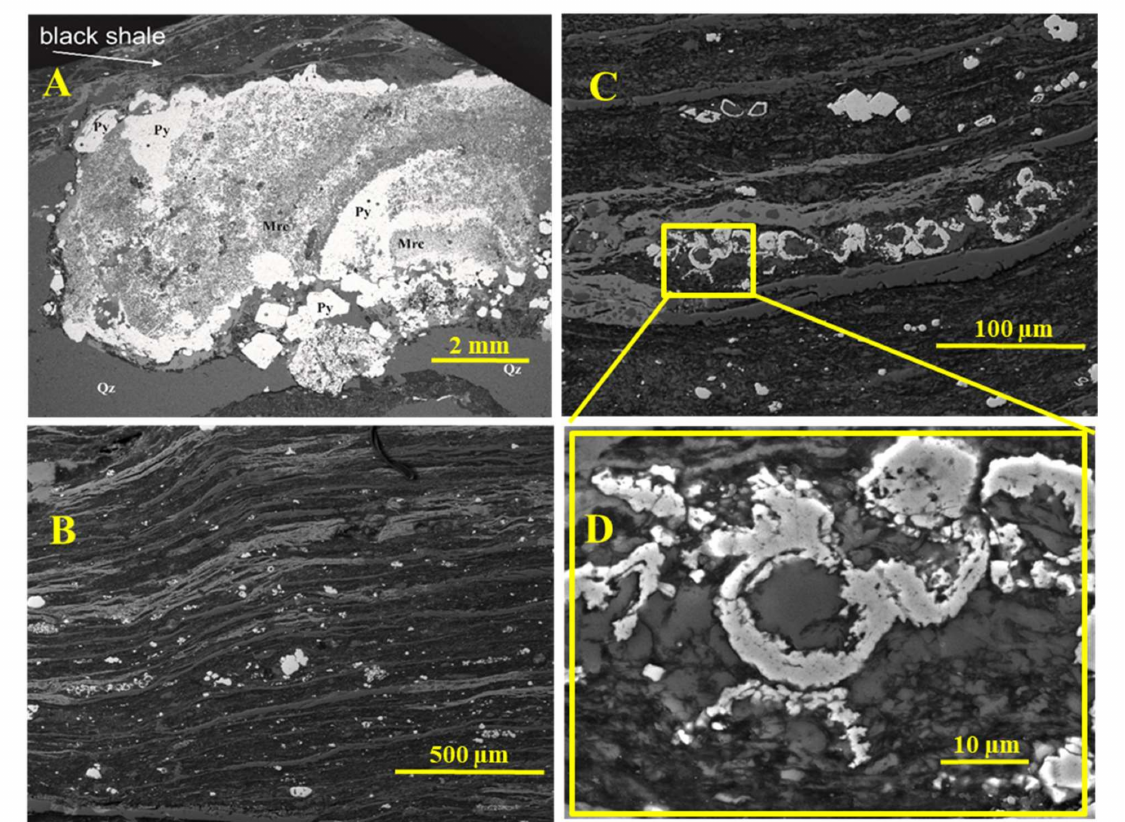
Figure 3. BSE images of pyrite grains from drill cores of the Leksa deposit: ( A ) concentrically laminated pyrite. Note that euhedral pyrite crystals (approximately 0.5 mm in diameter and less) occur around the laminated grain; ( B ) Disseminated euhedral pyrite crystals; ( C ) Micro-sized euhedral pyrite crystals observed as ring-shaped aggregates; Image ( D ) shows magnified view of marked area in ( C